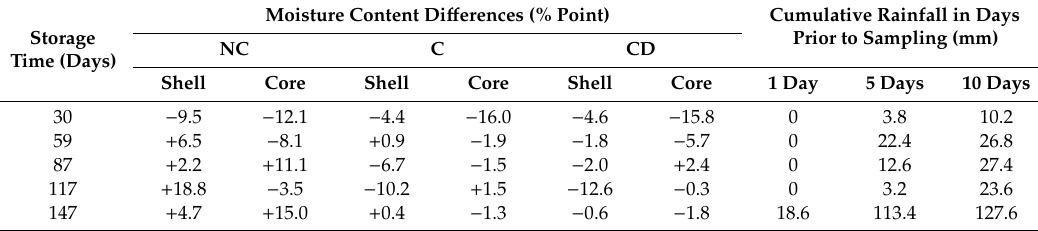
Table 2. Changes in moisture content from previous sampling period and cumulative rainfall over one, five, and 10 days prior to the dates when the samples were collected from poplar and willow chip piles (NC—no cover on pile; C—covered pile; CD—covered pile with dome ventilation). A positive sign indicates an increase in moisture content, and a negative sign shows a decrease in moisture